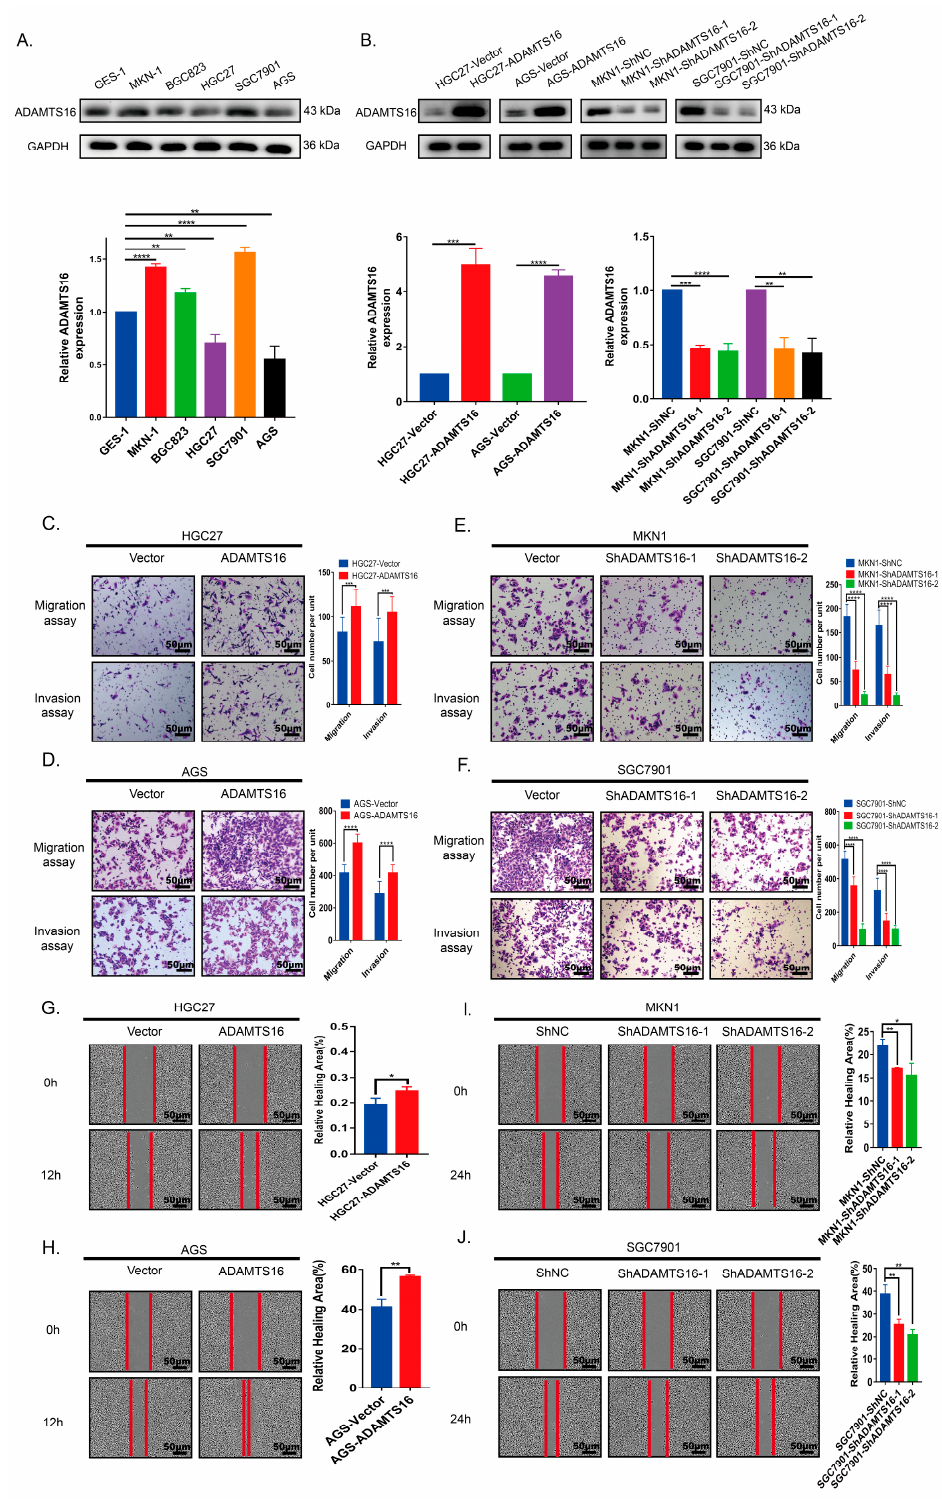
Figure 1. ADAMTS16 promotes GC cell migration and invasion in vitro. ( A ) Quantitation and western blot analysis of ADAMTS16 protein expression in five GC cell lines (MKN1, BGC823, HGC27, SGC7901, and AGS) and normal gastric epithelial cells (GES1). ( B ) The expression of ADAMTS16 in stably transfected cells was confirmed by quantitation and western blot analysis. ( C – F ) Transwell